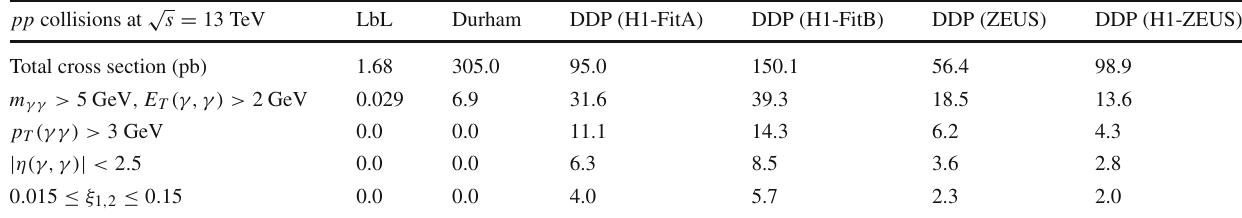
Table 3 Predictions for double diffractive diphoton cross sections after the inclusion of the exclusivity cuts for a typical forward detector. For comparison the predictions associated to the LbL scattering and exclusive (Durham) process are also presented √ pp collisions at s = 13 TeV LbL Durham DDP (H1-FitA) DDP (H1-FitB) DDP (ZEUS) DDP (H1-ZEUS) Total cross section (pb)